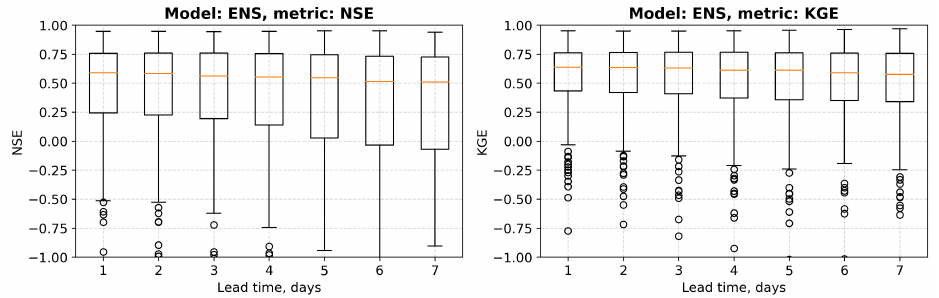
Figure 7. Verification of the ensemble mean forecast (ENS) in terms of NSE ( left plot ) and KGE ( right plot ) for the entire verification period and the entire set of reference gauges. The boxplot box represents the interquartile range (IQR, the difference between the 25th and 75th quantiles); the whiskers represent ± 1.5 × IQR from the 25th and 75th quantiles, respectively; the yellow line denotes the median